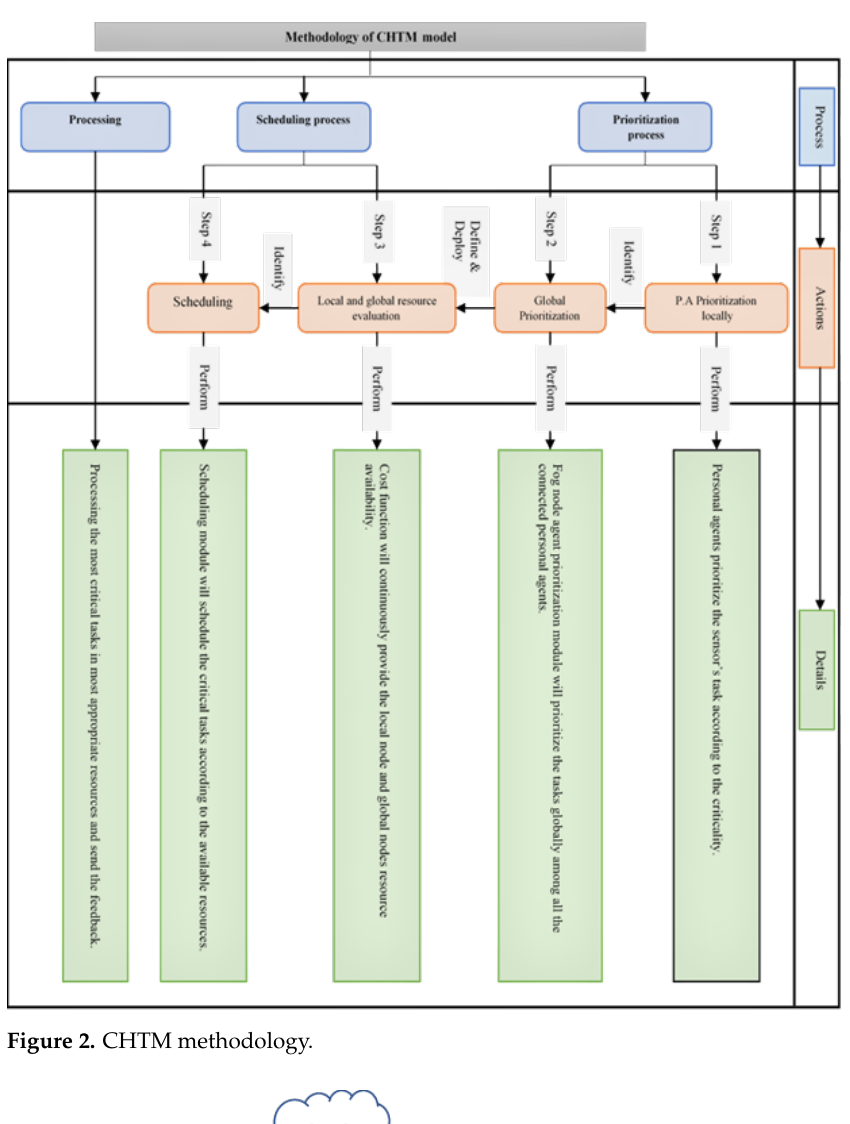
Figure 2. CHTM methodology.